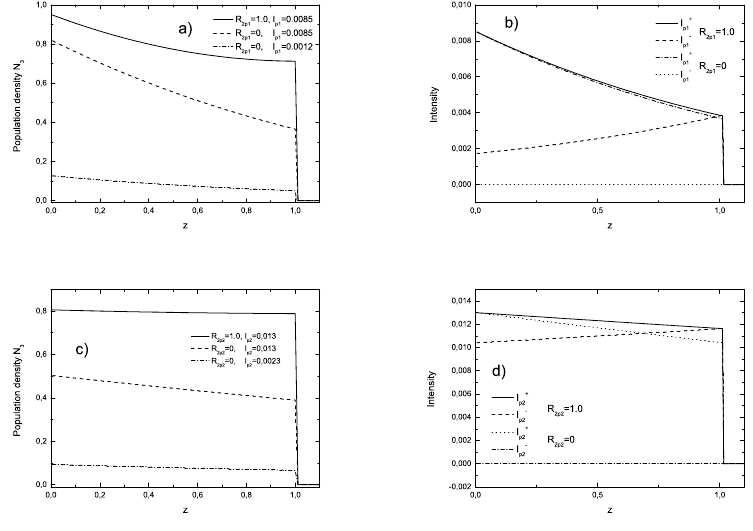
Figure 8. Spatial dependences (along the AE) of the population densities N 3 and pump intensities I p for the indirect a , b and direct c , d pumping.